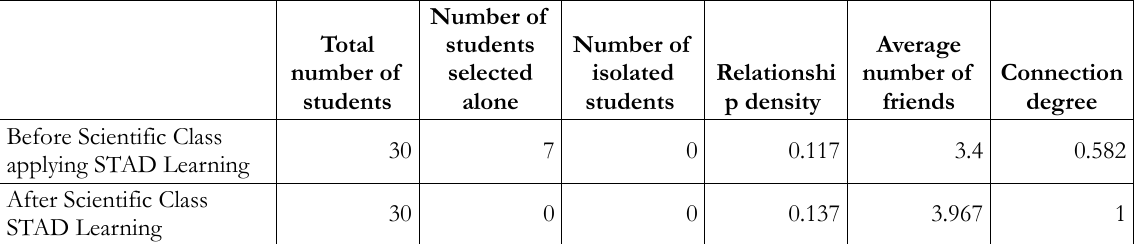
Table 7. The Relational Index of the